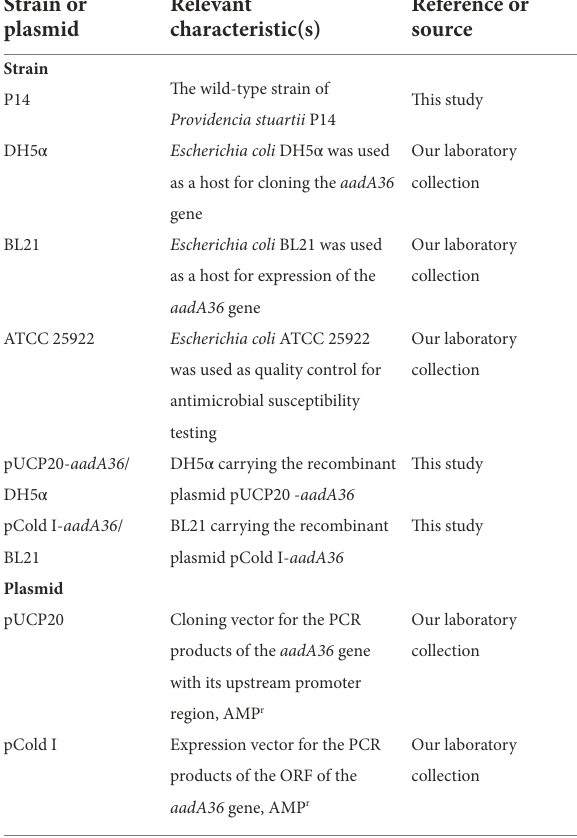
TABLE 1 Bacteria and plasmids used in this